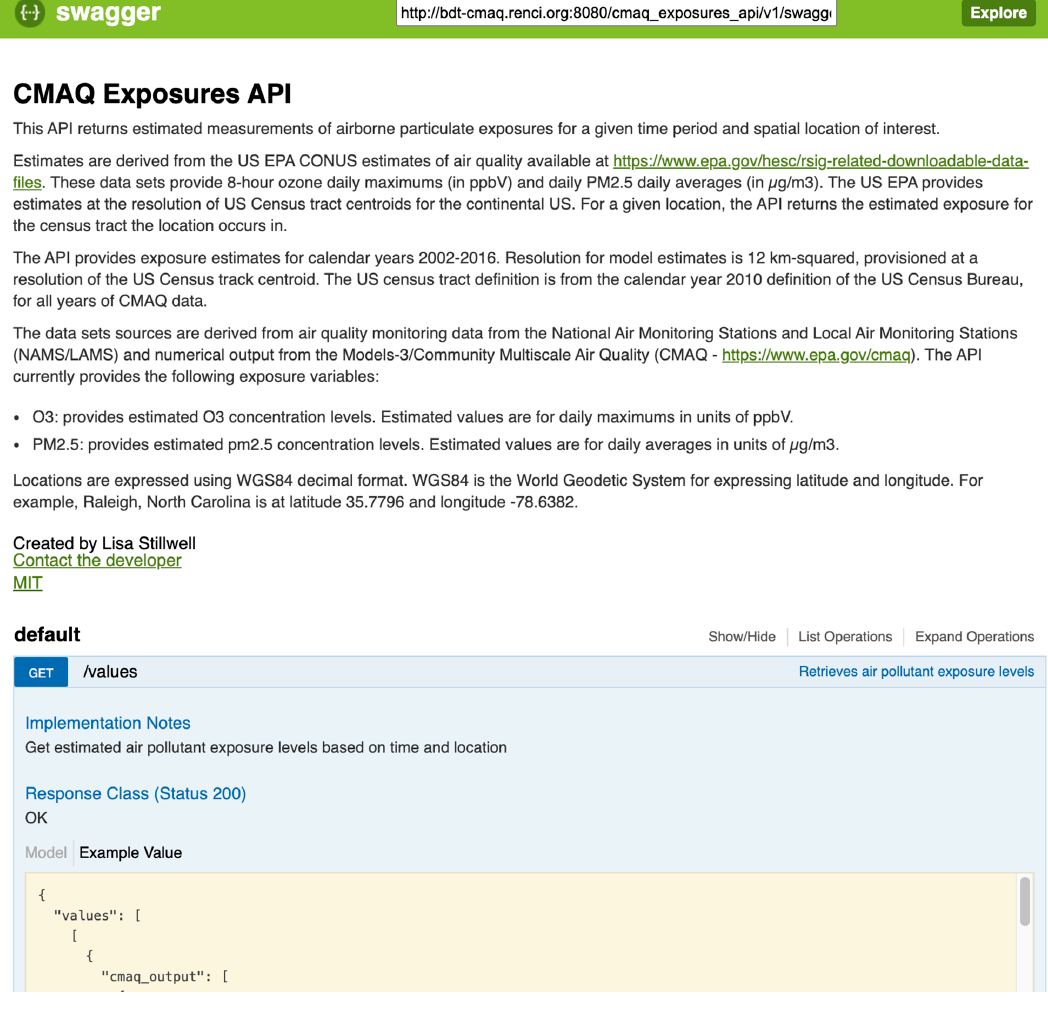
Figure 1. Screenshot of Swagger user interface to Translator Airborne Pollutant Exposures application programming interfaces (API).